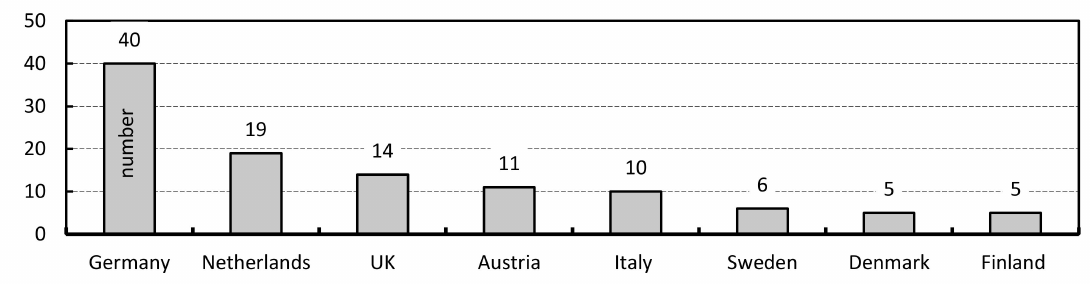
Figure 16. Number of